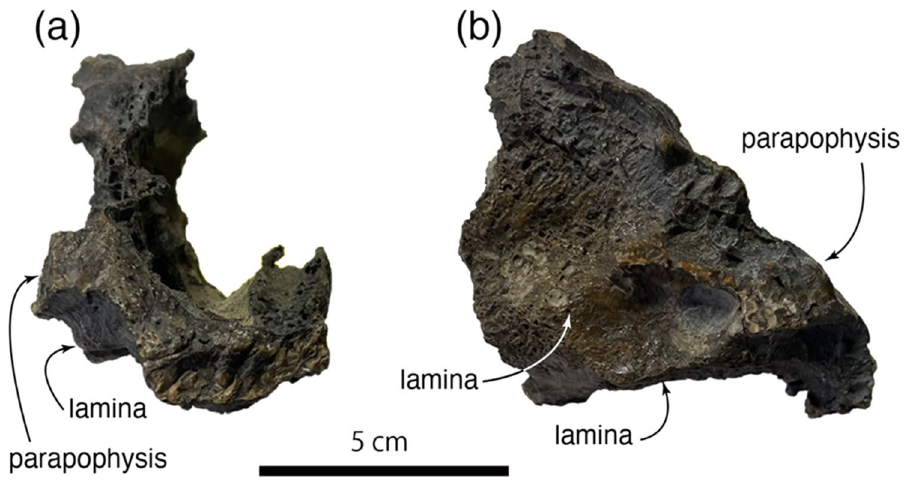
Figure 2. A partial vertebra of Paralitherizinosauruss japonicus gen. et sp. nov. in anterior ( a ) and right lateral ( b ) views. This figure was created by using Adobe Photoshop 21.2.0 and Adobe Illustrator 24.2.1 (https:// www. adobe. com/).